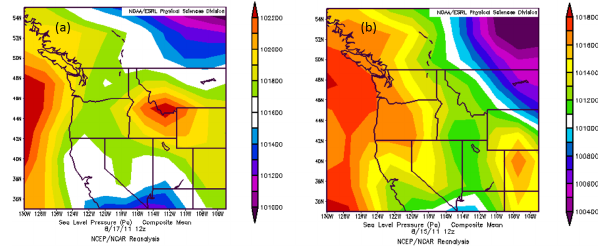
Figure 17. Synoptic-scale surface pressure conditions conducive to (a) enhanced easterly flow and (b) typical diurnal flow scenarios at the Salmon River Canyon site. North American Regional Reanaly- sis data courtesy of the National Center for Environmental Predic-